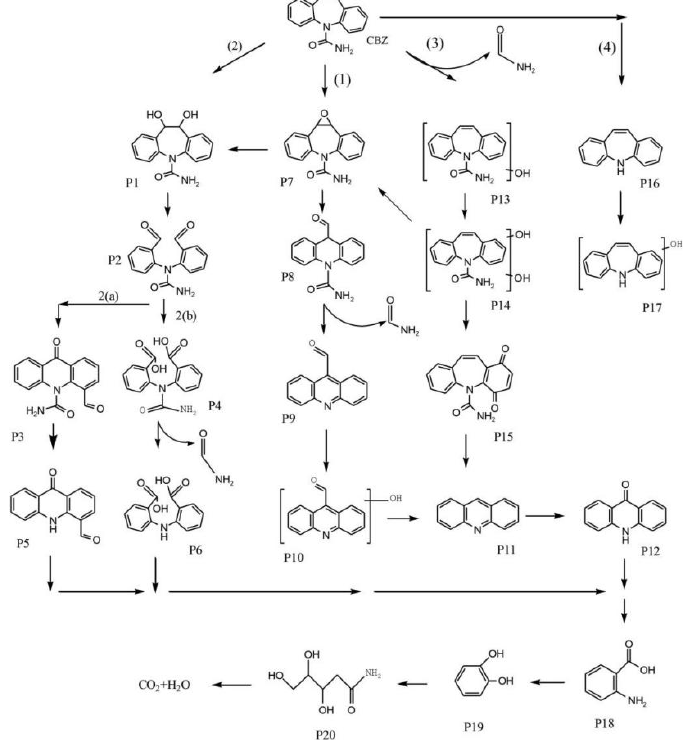
Figure 8. Degradation pathway of CBZ in the EF process with FeS 2 /CF as a cathode. Reproduced with permission from [145].